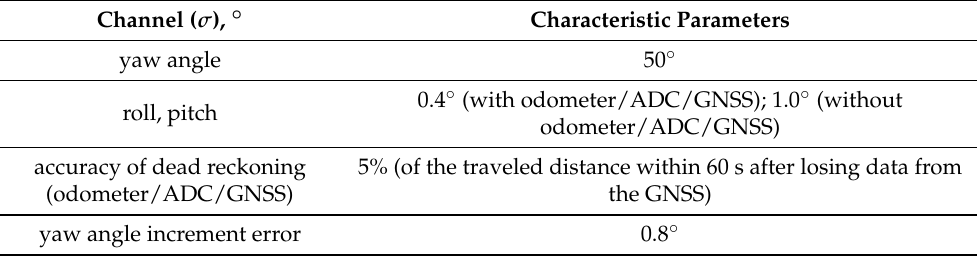
Figure 1. MEMS-strap-down inertial navigation system (SINS) GL VG 109. Table 2. The parameters of the MEMS-SINS GL VG 109. ADC, is air data